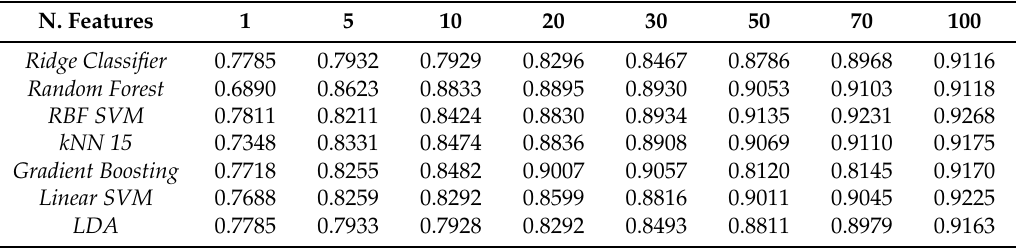
Table 3. Mean accuracies attained by the best selector for each classifier. The granularity of the table reduces as the feature subset size increases because of the lower accuracy variation between